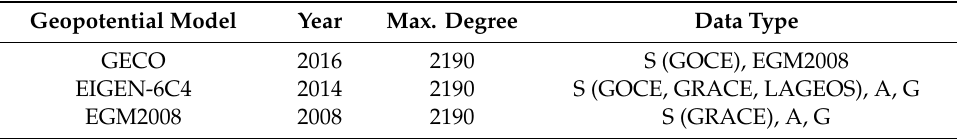
Table 2. Characteristics of the GGMs used in this